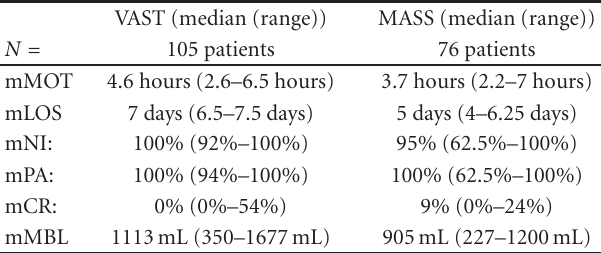
Table 3: Minimally invasive spine surgery outcomes summary. VAST: Video-assisted thoracoscopy; MASS: Minimal access spine surgery; mMOT: Median mean operating time; mLOS: